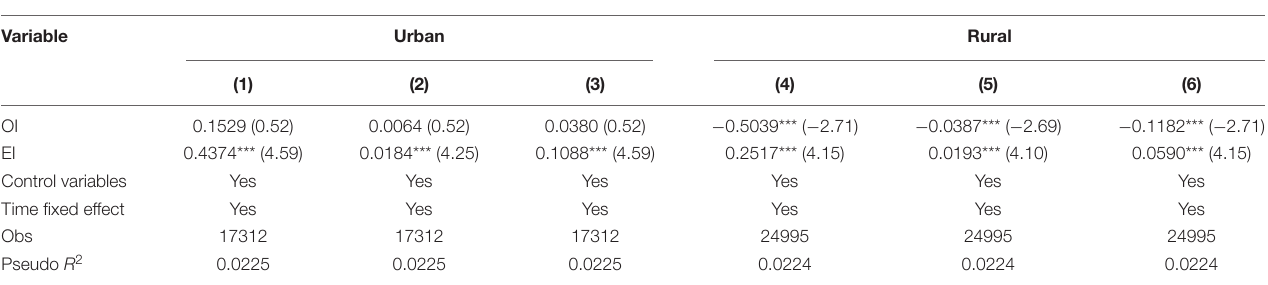
TABLE 4 | The difference of regional regression